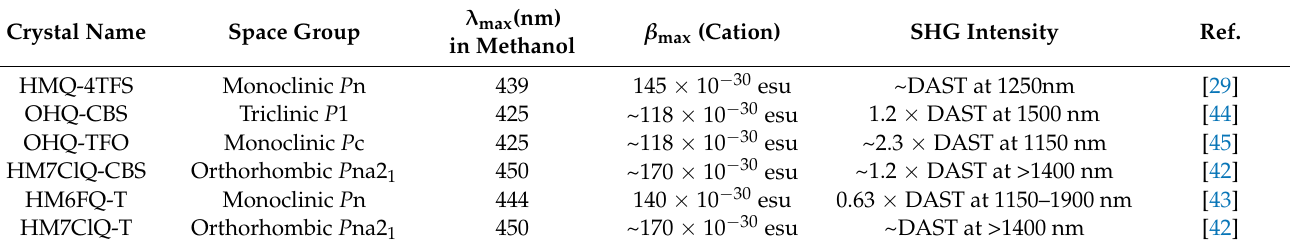
Figure 7. ( a ) Packing diagram of HM6FQ-T [43] crystal along the crystallographic a -axis and ( b ) arrangement of HM7ClQ-T along the b -axis [42]. Table 2. Comparison of the mentioned quinolinium-based THz crystals. Table 2. Comparison of the mentioned quinolinium-based THz